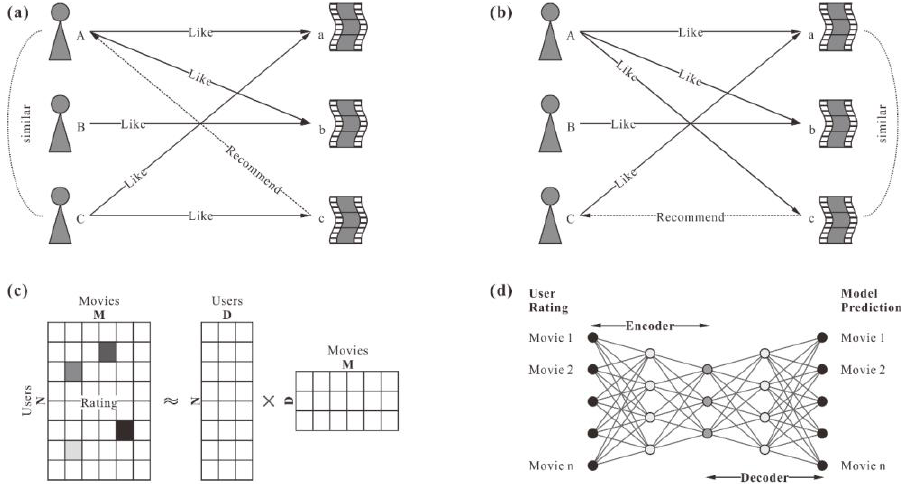
Figure 1. Typical recommendation methods. ( a ) User-based collaborative filtering, ( b ) Item-based collaborative filtering, ( c ) Model-based collaborative filtering, ( d ) Deep-learning neural networks.